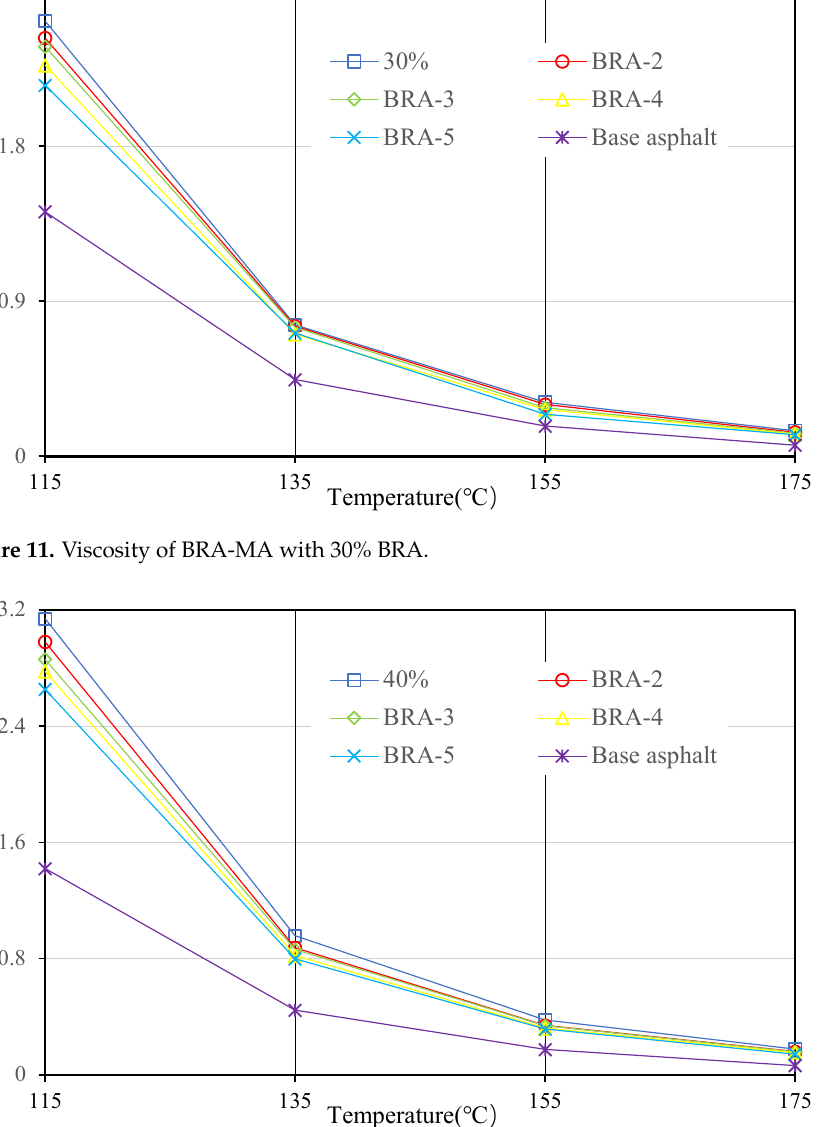
Figure 12. Viscosity of BRA-MA with 40% BRA.